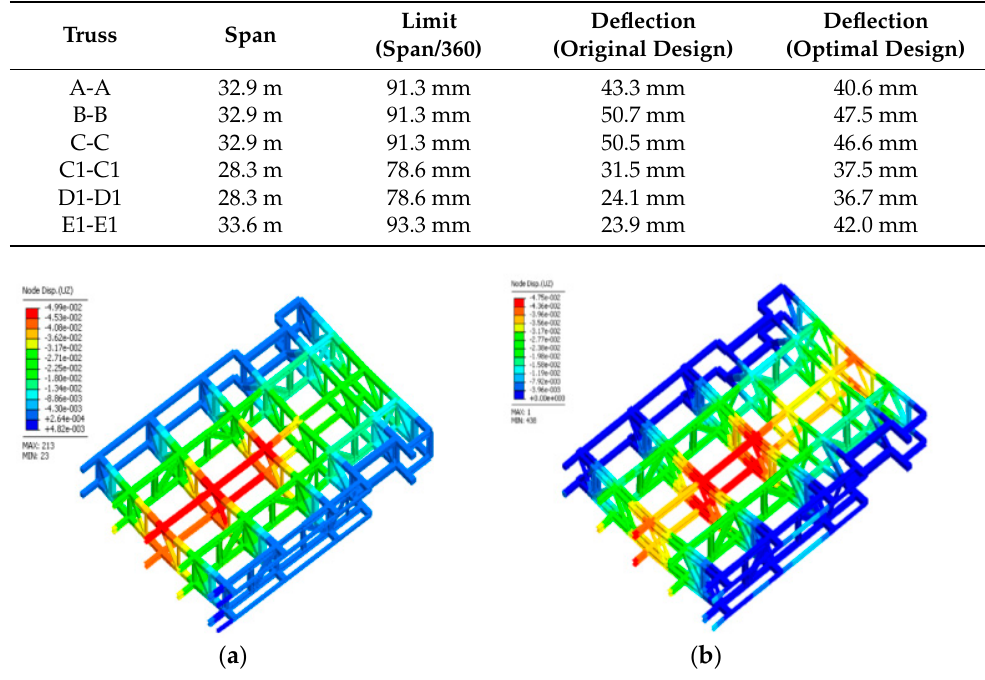
Figure 8. Comparison of vertical displacements from NIDA. ( a ) Original design; ( b ) Optimal design.